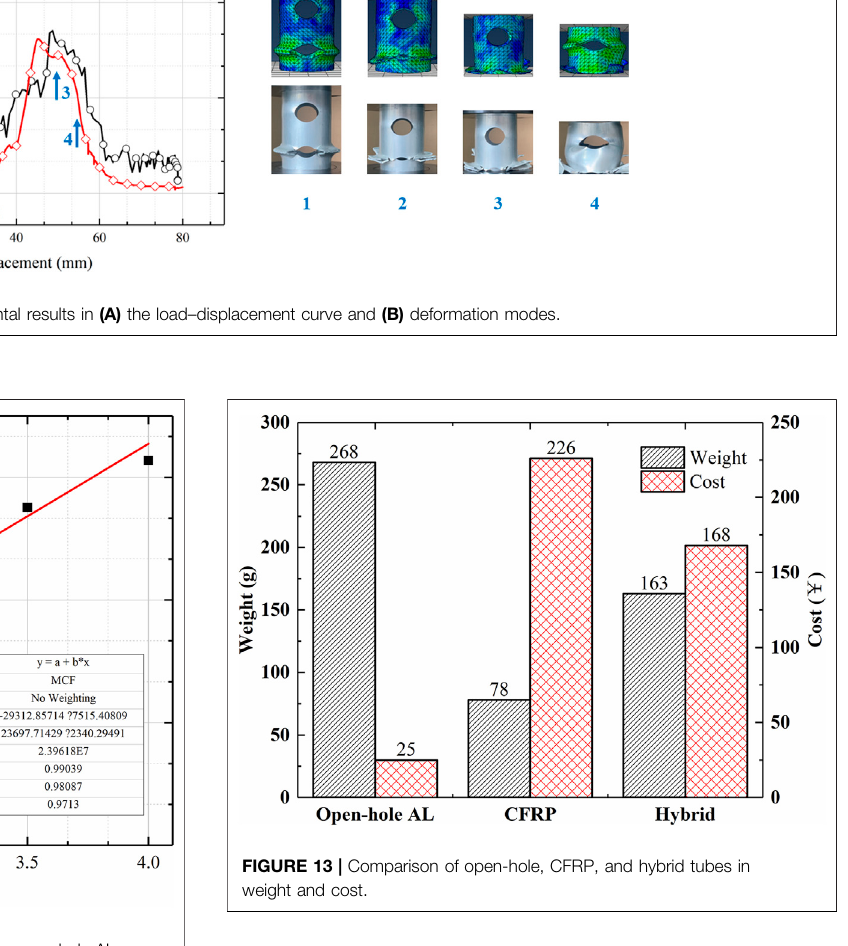
FIGURE 11 | Fitting curve of mean crushing force of the open-hole AL tube based on veri fi ed simulation results.